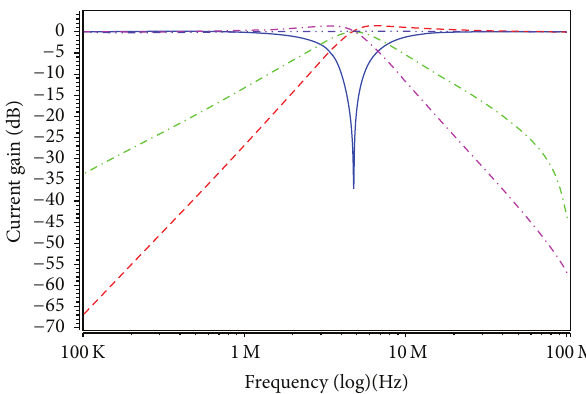
Figure 10: The input (blue line) and output (red line) waveforms of the BP response for a 2.72 MHz sinusoidal input current of 40 𝜇 A (peak to peak).